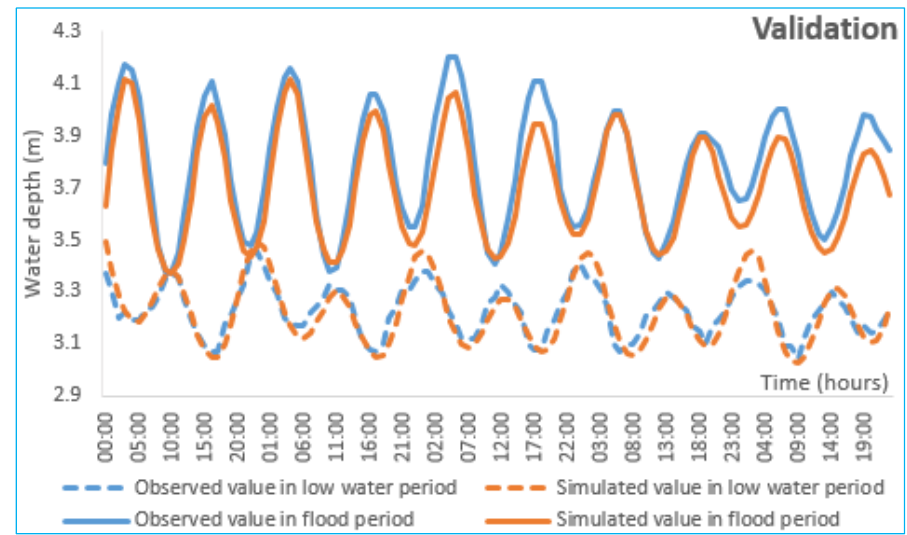
Figure 5. Variation of the water depth observed and simulated in flood and low water period during validation.